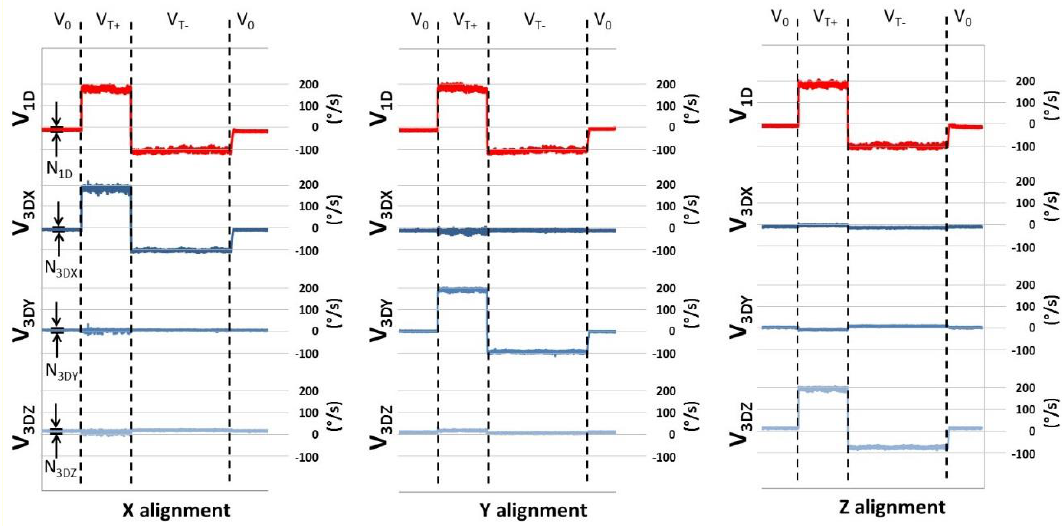
Figure 5. Angular velocity signals recorded with 1D gyro (V 1D in red line) and with 3D gyro (three components: V 3DX , V 3DY , and V 3DZ in blue gradations) during each X, Y, Z alignment; N 1D = estimated noise for 1D gyro; N 3DX , N 3DY , and N 3DZ = estimated noises for each detecting axis, used to obtain the noise level for 3D gyro (N 3D ). Table 1. Results of t -test analysis used for comparative evaluations between 3D gyro ( V 3D ) and 1D gyro (V 1D ) recordings. p value < 0.05 indicates statistically significant differences.